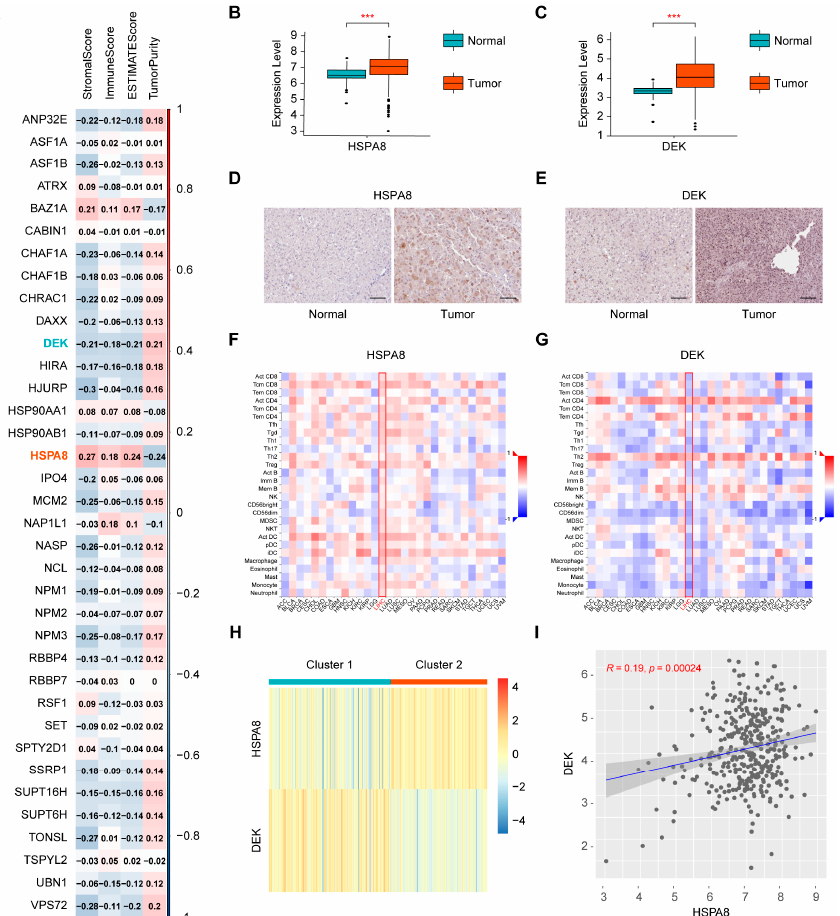
Figure 1. Screening of immune-related histone chaperones and clustering of 369 TCGA-HCC samples based on HSPA8 and DEK . ( A ) Correlation analysis between 36 known histone chaperones and the four ESTIMATE indices, including stromal score, immune score, ESTIMATE score and tumor purity. ( B , C ) Comparison of the mRNA expression of HSPA8 or DEK between tumor and normal tissues from the TCGA database. ( D , E ) Comparison of the protein level of HSPA8 or DEK between tumor and normal tissues from the HPA database. Scale bar, 100 µm. ( F , G ) Correlation analysis between HSPA8 or DEK and the abundance of tumor-infiltrating lymphocytes by TISIDB. ( H ) TCGA-HCC samples are divided into two clusters according to HSPA8 and DEK via consensus clus- tering. ( I ) Spearman rank correlation analysis between the expression of HSPA8 and DEK . *** p < 0.001. 2.2. Comparison of Immune Infiltration between the Two Clusters To obtain a comprehensive understanding of tumor immunity in the two clusters, the four ESTIMATE indices were calculated and Cluster 2 was found to have a higher stromal score, immune score and ESTIMATE score, but lower tumor purity than Cluster 1 (Figure 2A–D). In addition, a CIBERSORT analysis showed differences in the proportion of partial immune cells between the two clusters (Figure 2E). Importantly, a single-sample gene set enrichment analysis (ssGSEA) demonstrated that Cluster 2 had a higher expres- sion of 24 immune cell subtypes (e.g., activated and immature B cells, activated and memory CD8 + T cells, activated and immature dendrite cells, natural killer cells, and nat- ural killer T cells) than Cluster 1 (Figure 2F). Moreover, the expression of major histocom- patibility complexes (MHCs) in Cluster 2 tended to be higher than that in Cluster 1 (Figure 2G). Taken together, Cluster 2 tended to have stronger immune infiltration than Cluster 1.